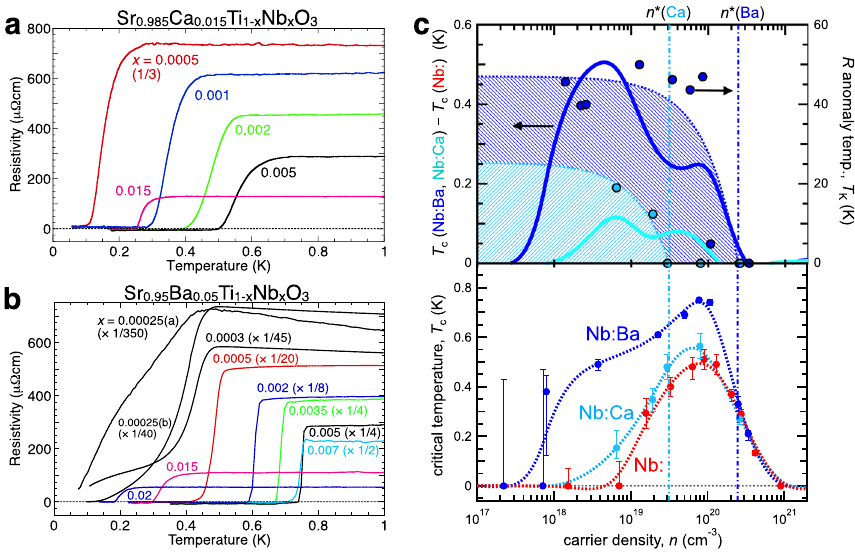
Fig. 4 Superconductivity of the polar metals Nb:Sr 0.985 Ca 0.015 TiO 3 and Nb:Sr 0.95 Ba 0.05 TiO 3 . a Resistivity of the Sr 0.985 Ca 0.015 Ti 1 − x Nb x O 3 single crystals (the same samples that were studied in Fig. 3a) below 1 K for 0.0005 ≤ x ≤ 0.015. b Resistivity of the Sr 0.95 Ba 0.05 Ti 1 − x Nb x O 3 single crystals (the same samples that were studied in Fig. 3c) below 1 K for 0.00025 ≤ x ≤ 0.02. c The bottom panel depicts the superconducting domes of the polar metals Nb:Sr 0.985 Ca 0.015 TiO 3 (denoted by Nb:Ca) and Nb:Sr 0.95 Ba 0.05 TiO 3 (Nb:Ba), along with that of the nonpolar Nb:SrTiO 3 (Nb:) that was shown in Fig. 2b. The carrier density n of this plot was measured based on the Hall effect at 5 K. The dashed lines were obtained by performing a smoothing spline interpolation, with the lines becoming negative in some regions. However, this behaviour is an artefact of the smoothing process and is negligibly small. Therefore, it does not affect the discussion here. The top panel shows a replot of the T K results shown in Fig. 3b and d versus the logarithmic values of n at T K . The dashed lines correspond to the solid lines shown in Fig. 3b and d. The systems are polar within the hatched regions. The solid lines represent the differences between the T c values of the polar metals and that of the nonpolar Nb:SrTiO 3 . In both the top and bottom panels, the dash-dotted vertical lines correspond to n * for Nb:Sr 0.985 Ca 0.015 TiO 3 (light blue), and n * for Nb:Sr 0.95 Ba 0.05 TiO 3 (dark